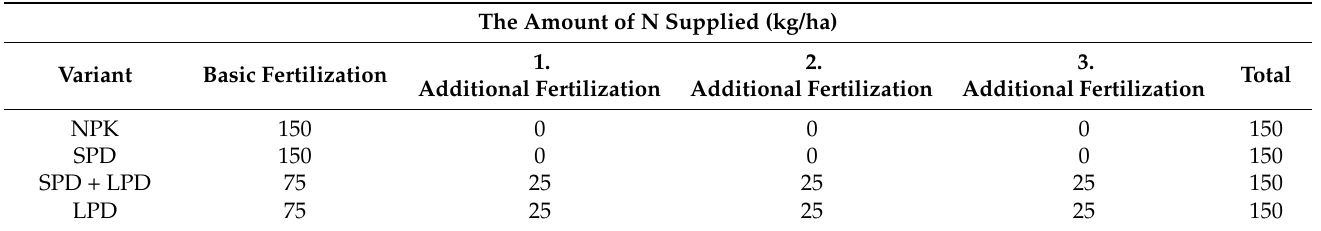
Table 1. The amount of nitrogen supplied in individual variants during vegetation. The Amount of N Supplied (kg/ha) Variant Basic